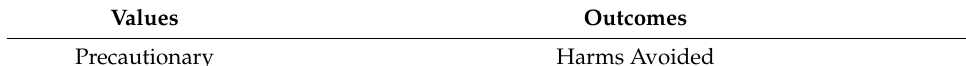
Table 4. Combining Japanese/Western Values in International Ethics